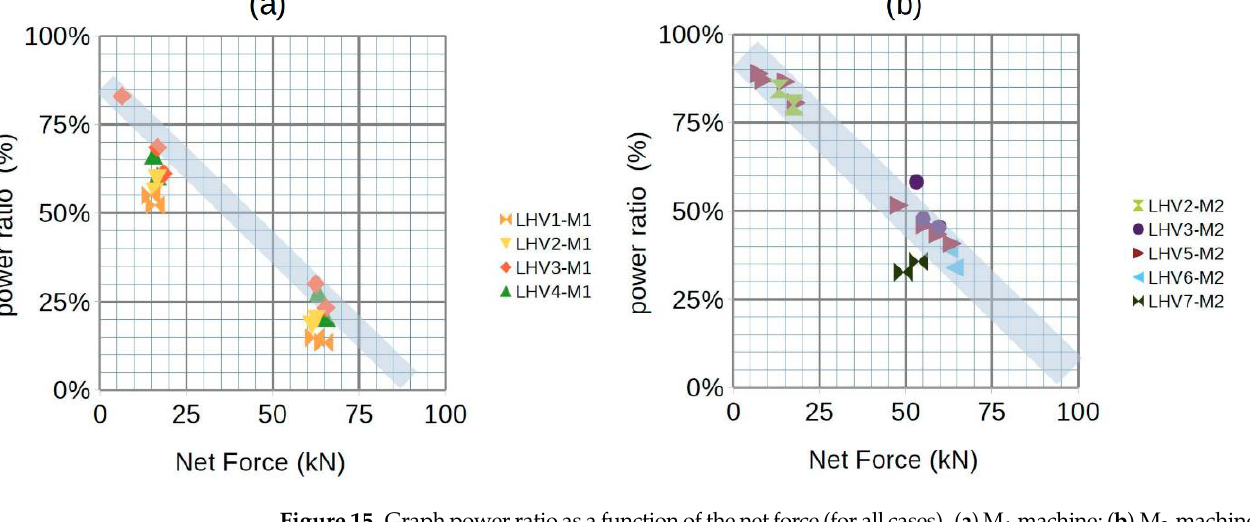
Figure 15. Graph power ratio as a function of the net force (for all cases). ( a ) M 1 machine; ( b ) M 2 machine.